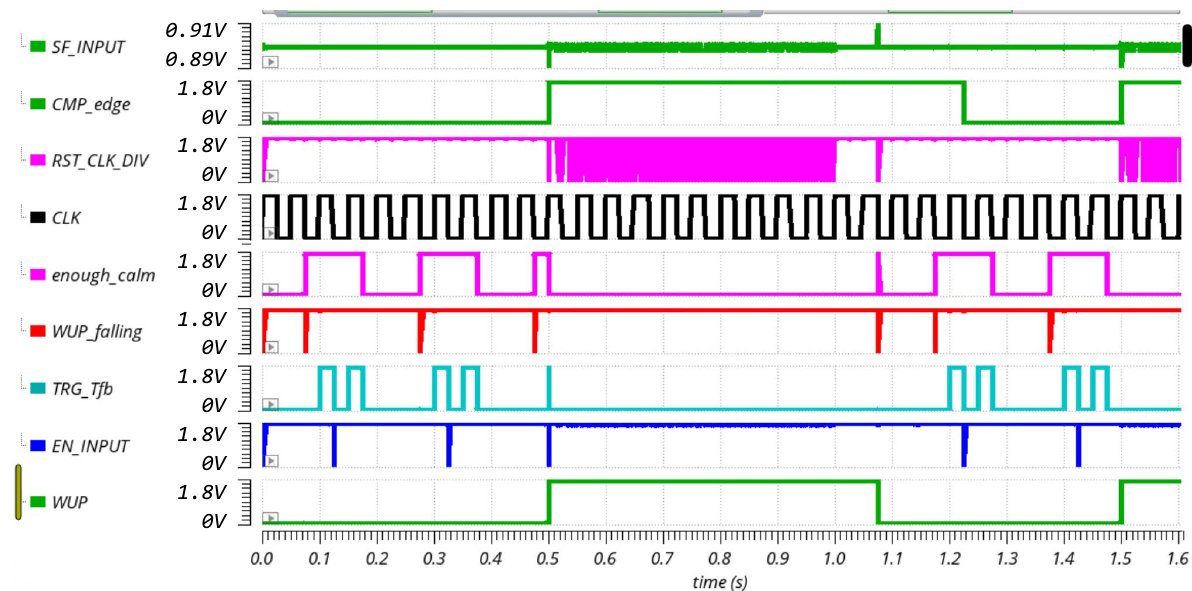
Figure 16. Full channel simulation results from SF to LOGIC.